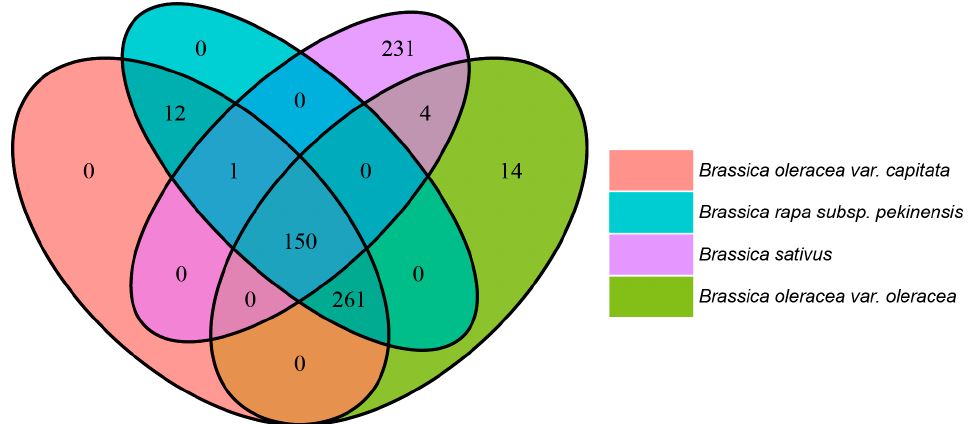
Figure 4. Metabolic pathway differences in Brassica oleracea var. capitata , Brassica oleracea var. oleracea , Raphanus sativus and Brassica rapa subsp. Pekinensis based on comparative genomics. The Venn diagram shows the similarity and differences between metabolic pathways among the four plant species: Brassica oleracea var. capitata (in orange), Brassica olearacea var. oleracea (in green), Brassica rapa subsp. Pekinensis (in blue, using PlantCyc databases) and Raphanus sativus (in violet, using RadishBase). The numbers in these Venn diagram represent the numbers of shared and unique metabolic pathways and sub-pathways in these species.